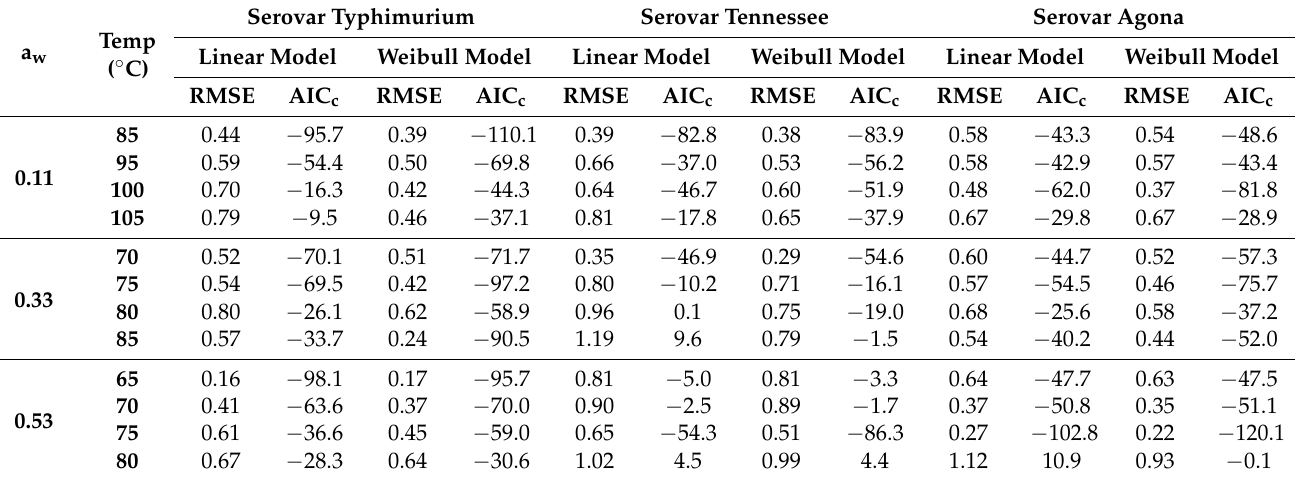
Table 1. Evaluation of the goodness-of-fit of the linear and Weibull models used to describe the inactivation of three Salmonella enterica serovars by means of the root mean square error (RMSE) and the corrected Akaike information criterion (AIC c ) calculated for each water activity and temperature in toasted oats cereal (TOC).